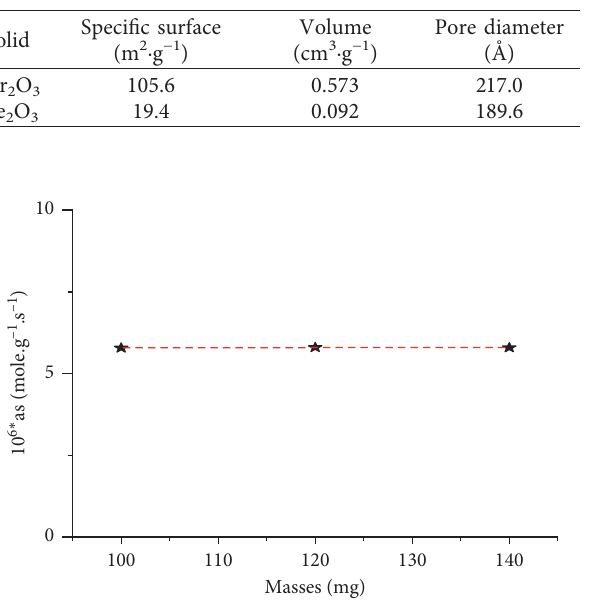
Figure 3: N 2 adsorption/desorption isotherms on Cr 2 O 3 and Fe 2 O 3 . Table 1: Textural characteristics of solids.